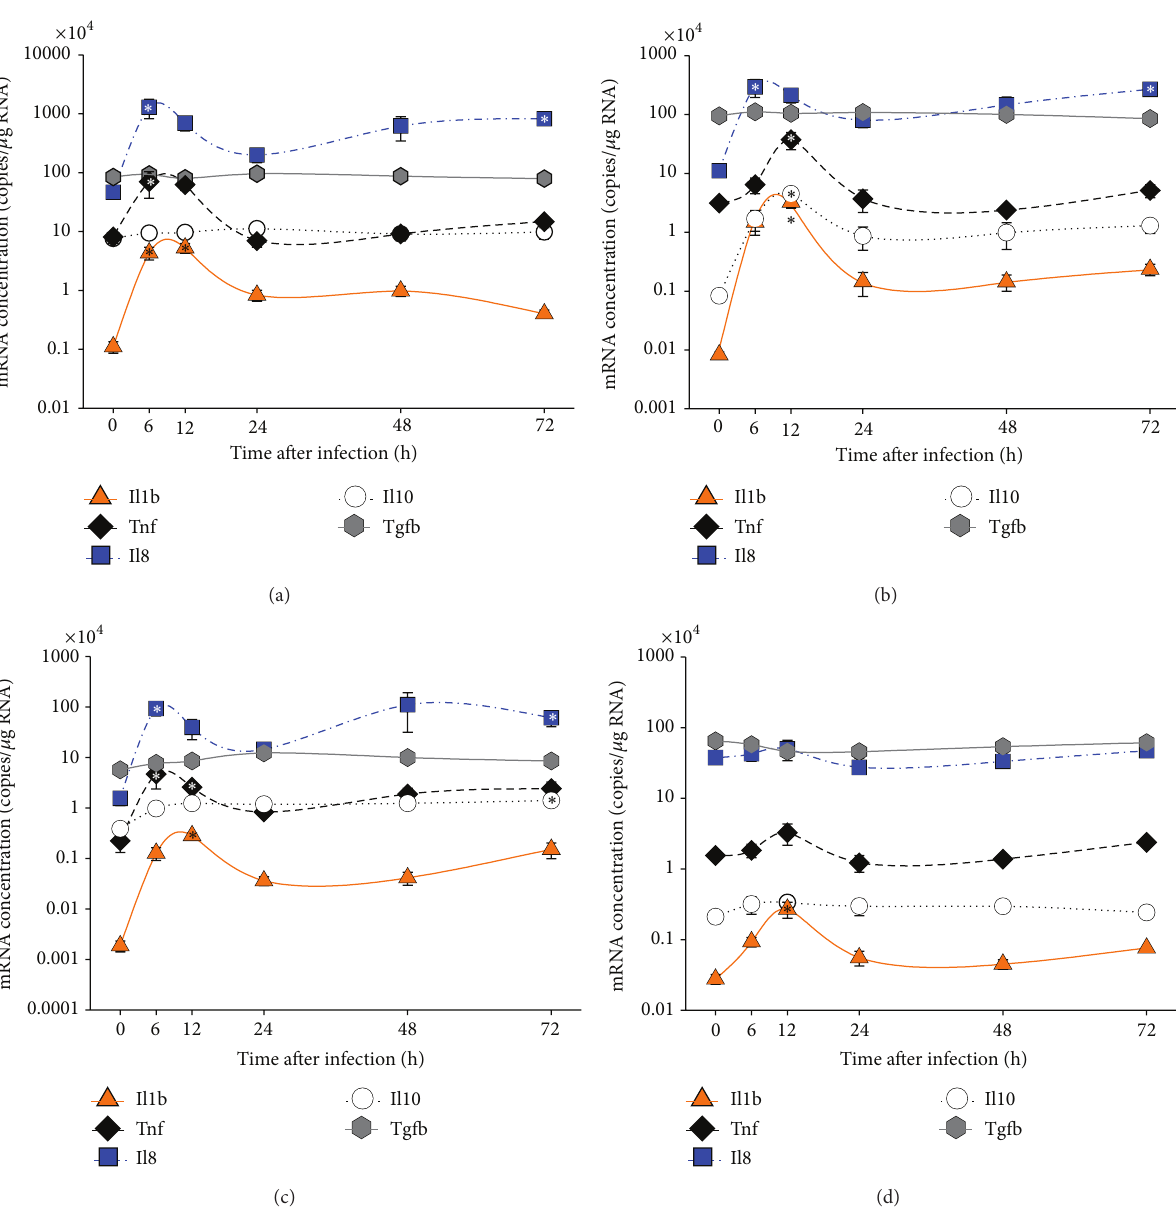
Figure 3: Relative levels of mRNAs encoding cytokines in selected immune organs of trout after infection with A. salmonicida . The relative number of mRNA copies (ordinate) encoding Il1b (triangles; full line), Tnf (diamonds; broken line), Il8 (squares; line-dot-line), Il10 (circles; dotted line), and Tgfb (hexagon; full gray line) is plotted against the time after infection (abscissa). Different tissues (a) spleen, (b) head kidney, (c) liver, and (d) thymus were collected from five individuals/time point. Values are given as mean ± SEM; the pertinent data are listed in Table 2. Note that the relative quantity is presented on a log10 scale. Asterisks indicate significant differences with 𝑝 < 0.05 compared to the control group